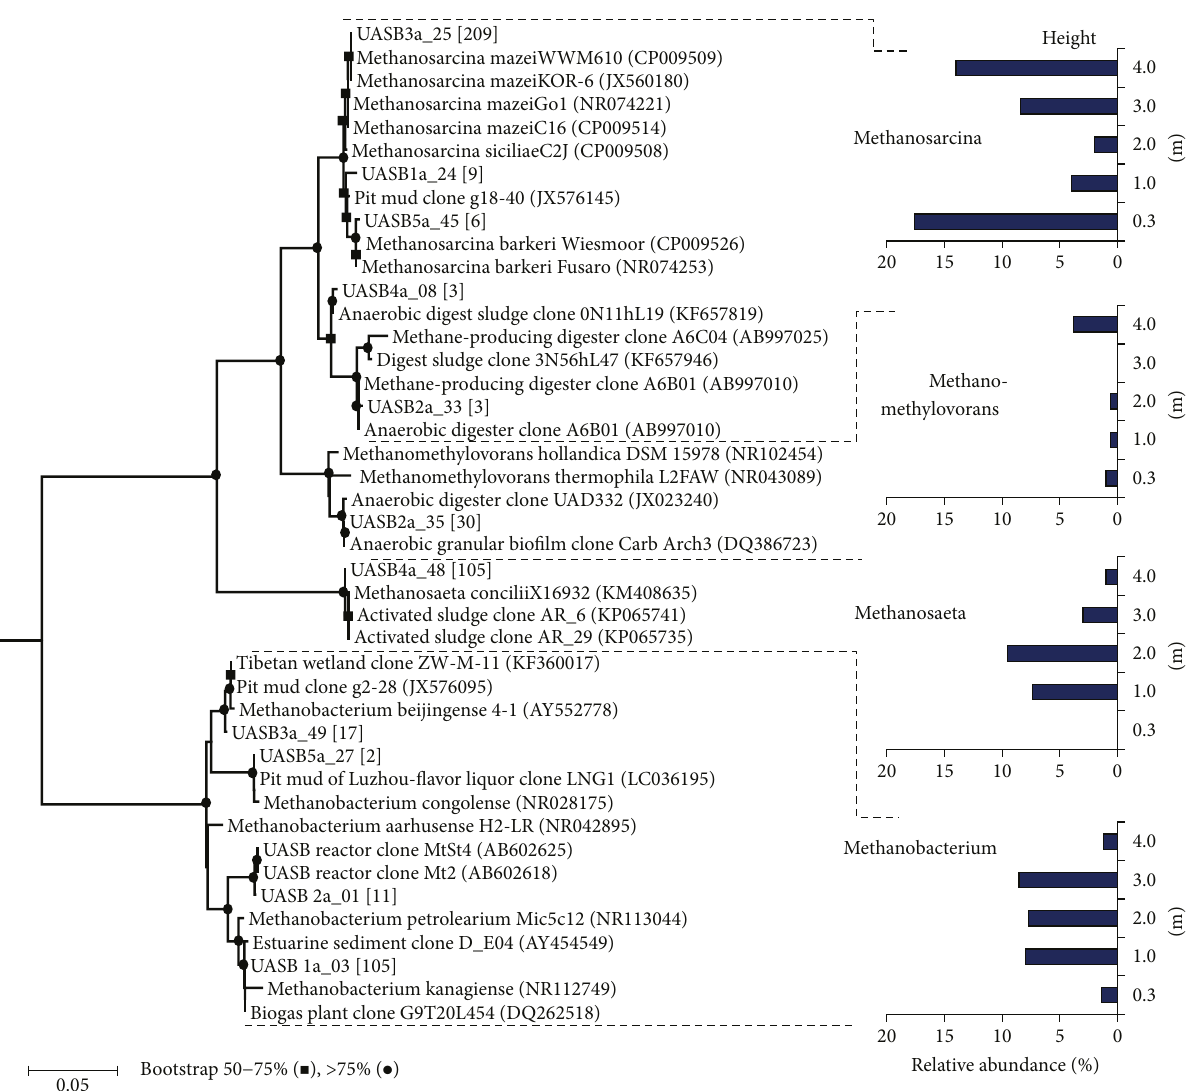
Figure 3: Phylogenetic tree and distribution of archaeal 16S rRNA genes retrieved from the sludge taken at various heights (0.3 – 4m) of the full-scale UASB reactor for treating tetramethylammonium-rich wastewater. The 16S rRNA gene sequences were obtained through the DGGE-cloning approach, and the representative clones were shown in bold in the tree. The values in the square brackets indicated the numbers of clones that were similar to the representative phylotypes ( > 99% sequence similarity). The 16S rRNA gene sequence of Methanopyrus kandleri (NC003551) was used as an outgroup to root the tree. Bootstrap values of 50 – 75% and > 75% were indicated with black circles and squares, respectively, at the nodes of the tree. The scale bar represented the estimated number of nucleotide changes per sequence